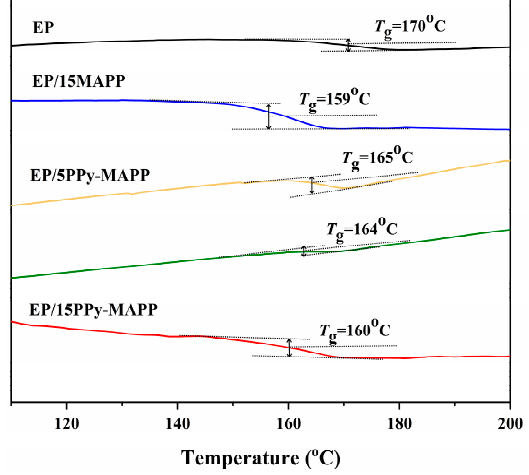
Figure 6. DSC curves of flame-retardant epoxy resin.